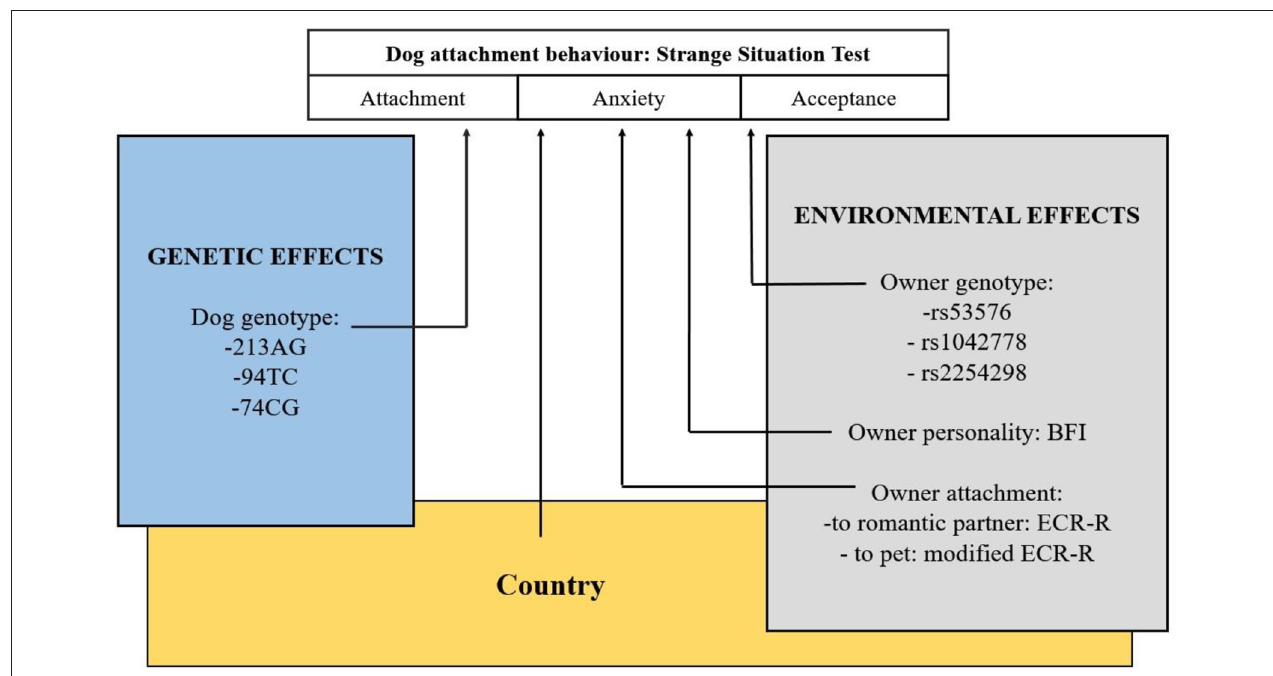
FIGURE 2 | Overview of the study. Examination of environmental and genetic associations of dogs’ attachment behavior to their owners. Another study (Kovács et al., 2016b ) investigating dogs’ social sensitivity has also found significant main effect of the same OXTR